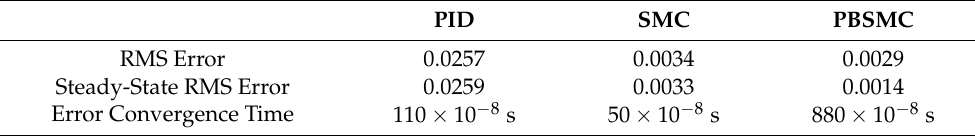
Table 10. Angular Rate Total Error Comparison for Experimental Data. Maximum Error for 10